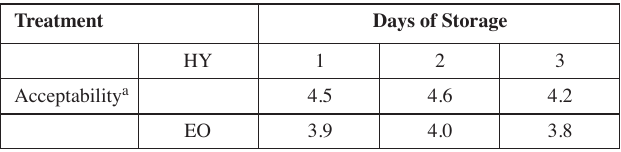
L. Tabti, M. El Amine Dib, N. Djabou, N. Gaouar Benyelles, J. Paolini, J. Costa, A. Muselli Tab. 4: Effect of essential oil (EO) and hydrosol (HY) on acceptability sensory scores of orange stored at 25 °C.